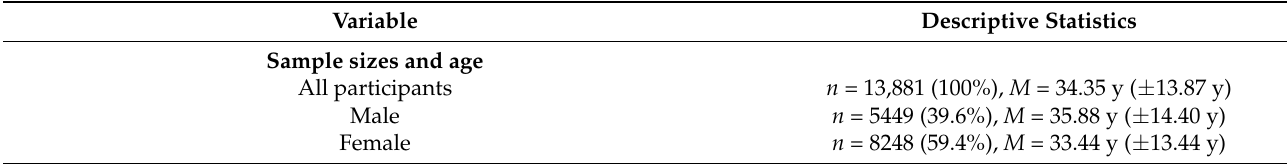
Table 1. Demographic variables and study sample